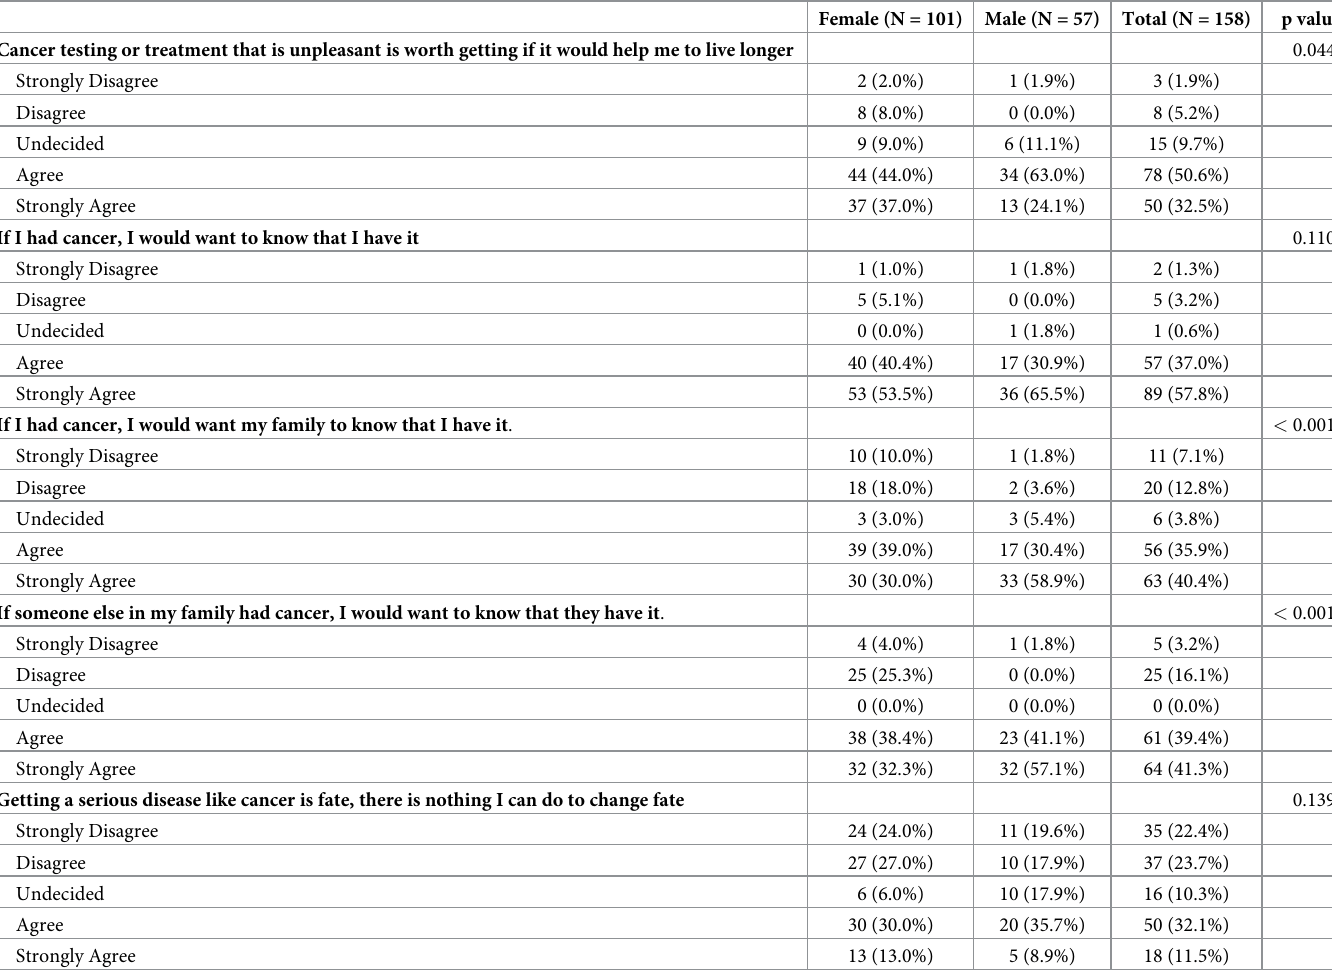
Table 5. Cancer attitudes by gender.